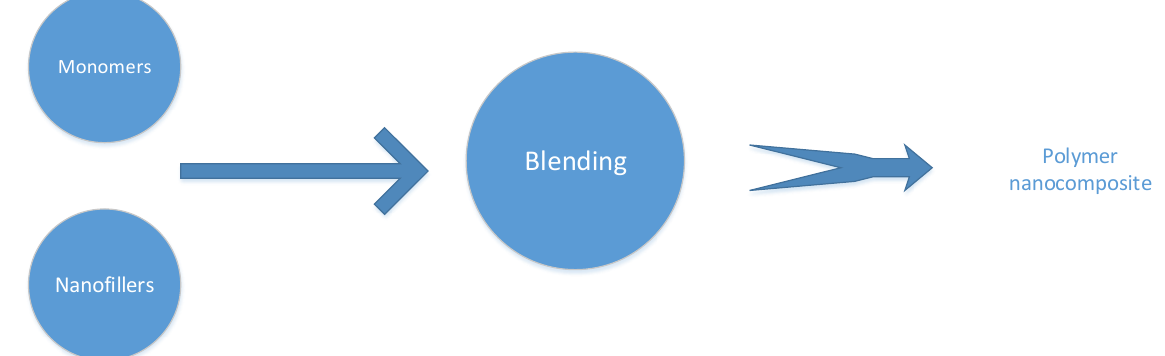
Figure 4. Steps to fabricate a PNC using the physical blending method.